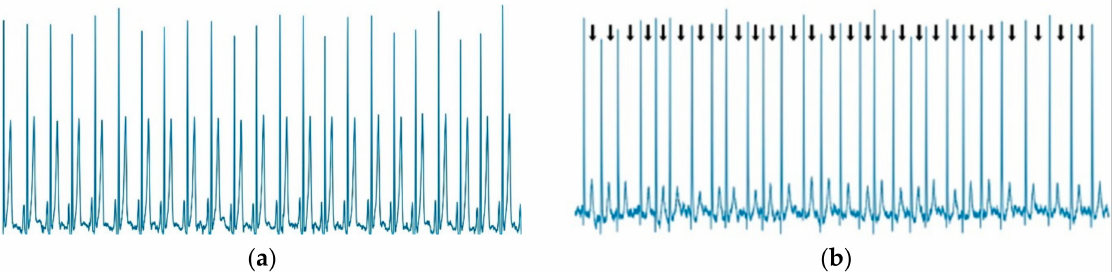
Figure 3. Example of ECG signal: ( a ) normal rhythm as NSR and ( b ) abnormal rhythm as